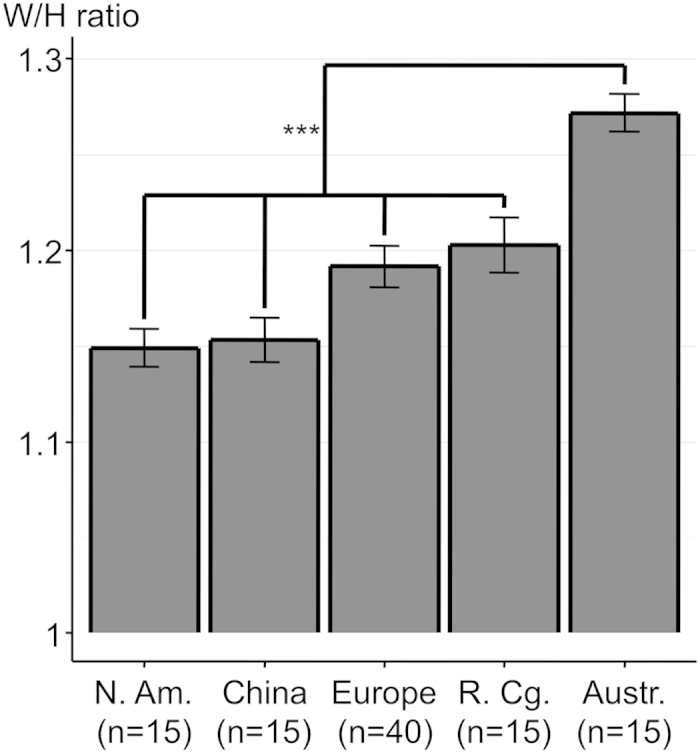
Histogram of the orbital width/height (W/H) ratio (mean + /– SEM) in different human populations.***p < 0.001. Abbreviations used: N. Am. = North America; R. Cg. = Republic of the Congo; Austr. = Australia.